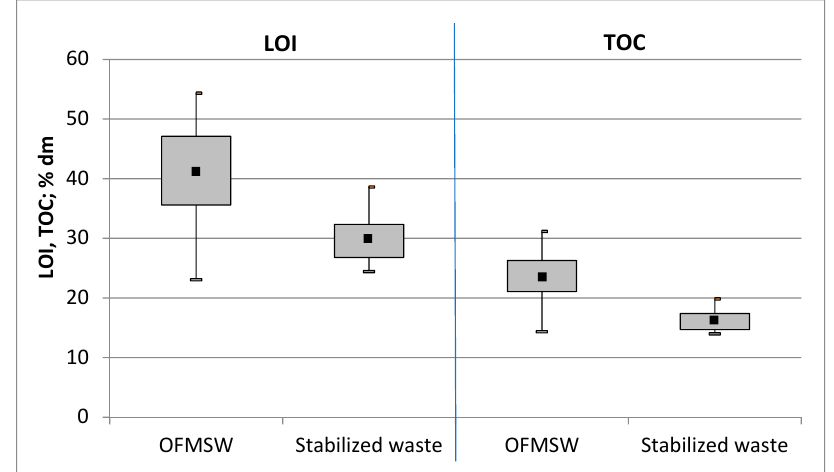
Figure 2. The range of the loss on ignition (LOI) and total organic carbon (TOC) parameters (% DM (dry matter)) obtained for 20 different waste samples from Polish mechanical–biological treatment (MBT) plants. The diagram includes the median, minimum, and maximum values, as well as the 25% and 75% quartiles.